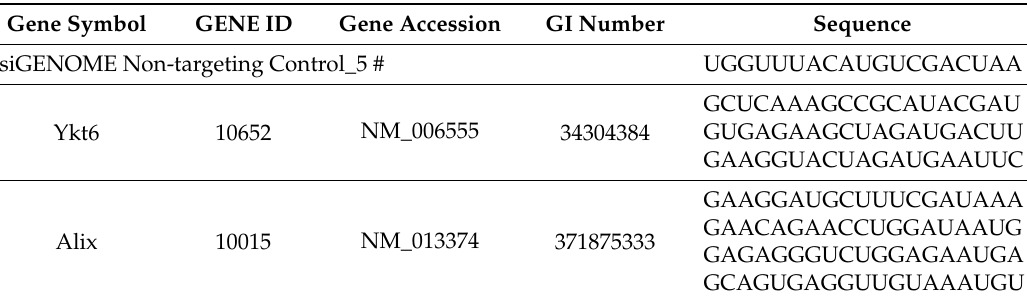
Table 1. Dharmacon siRNA